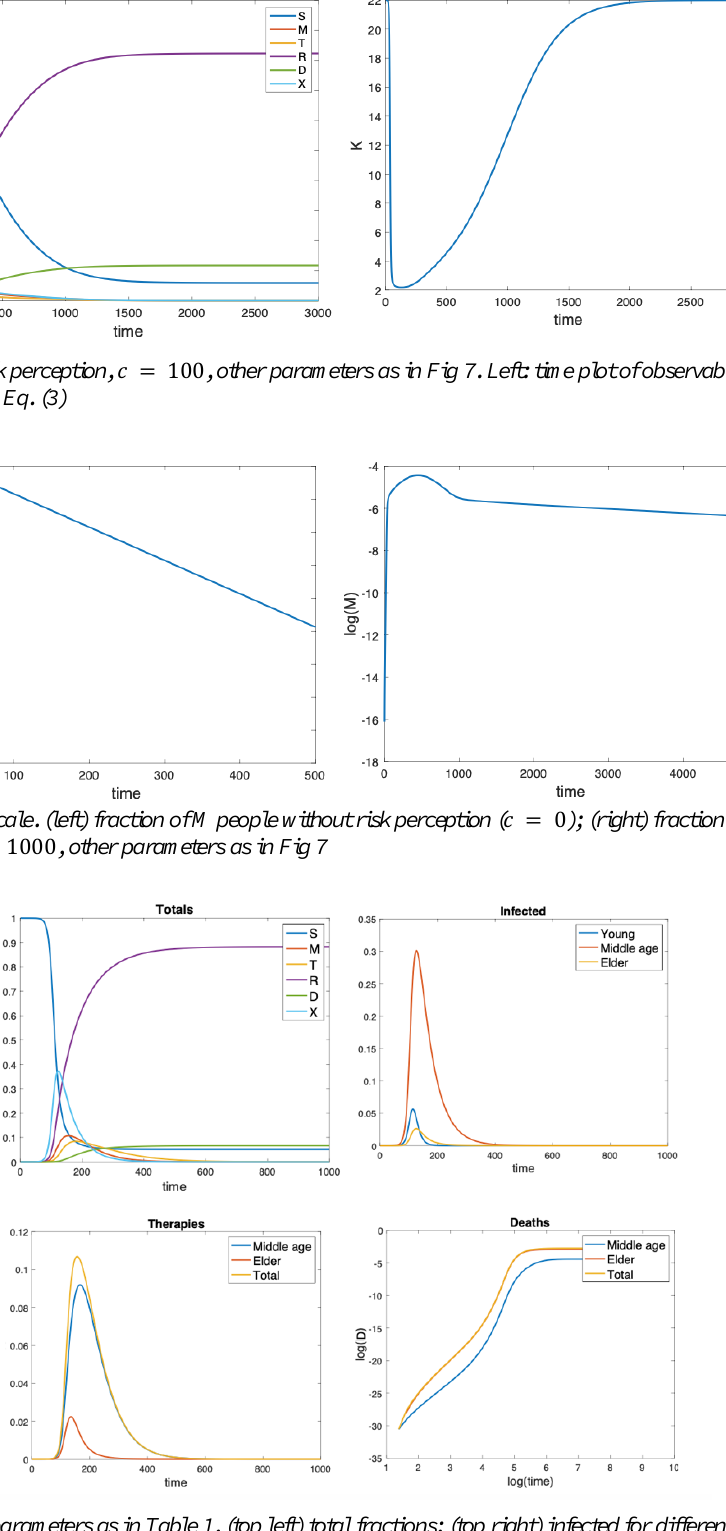
Figure 10. 𝑐 , other parameters as in Table 1. (top left) total fractions; (top right) infected for different age classes; (bottom 0 = 1 left) people in therapy; (bottom right) deaths on a log-log